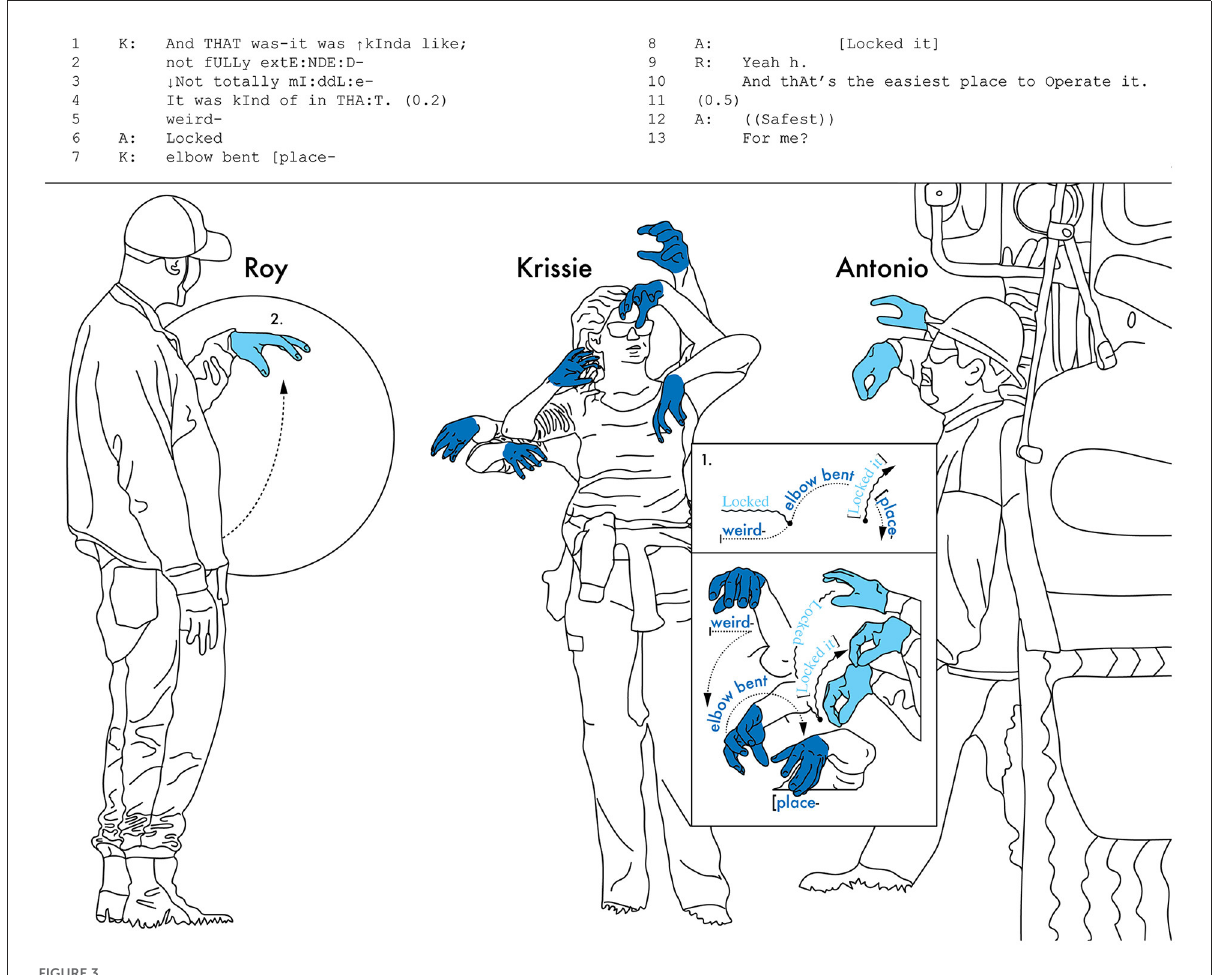
FIGURE3 Transcript